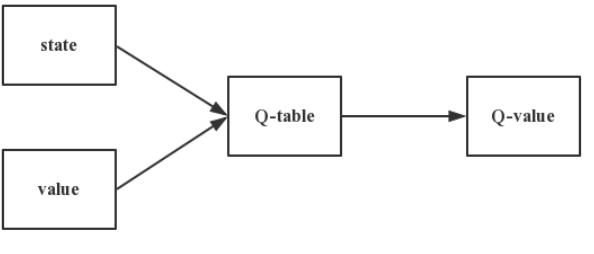
Figure 10. Process of